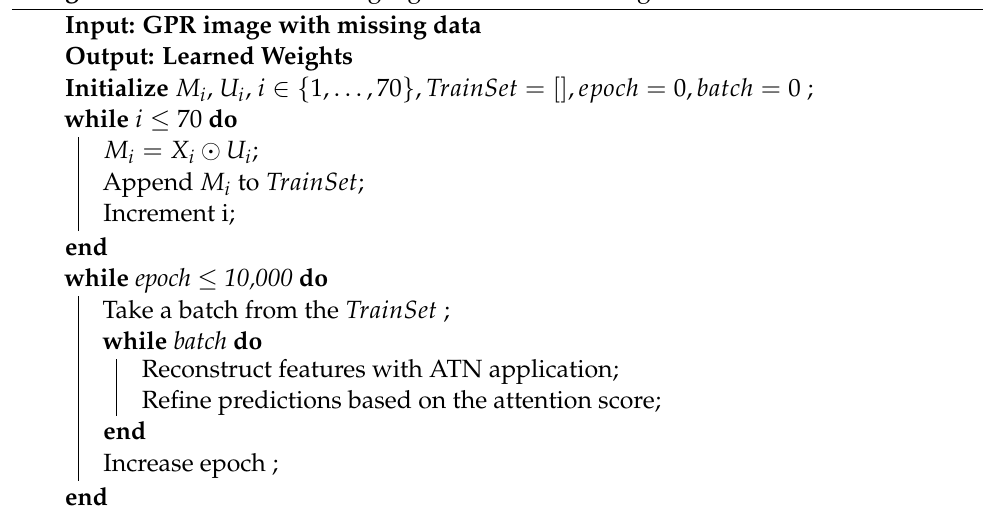
Algorithm 1: PEN-Net training algorithm on GPR